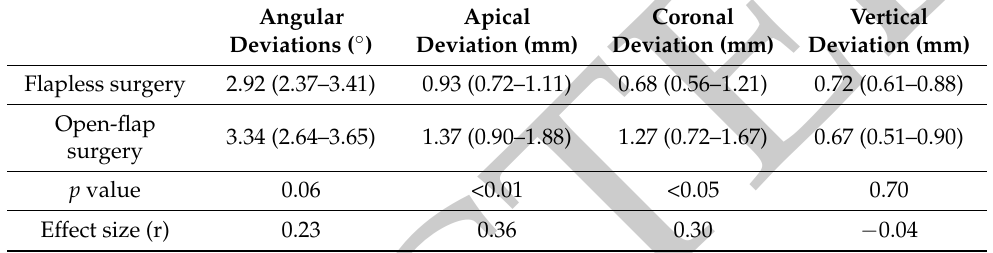
Table 3. Statistical comparisons between flapless surgery and open-flap surgery (Mann–Whitney U test).